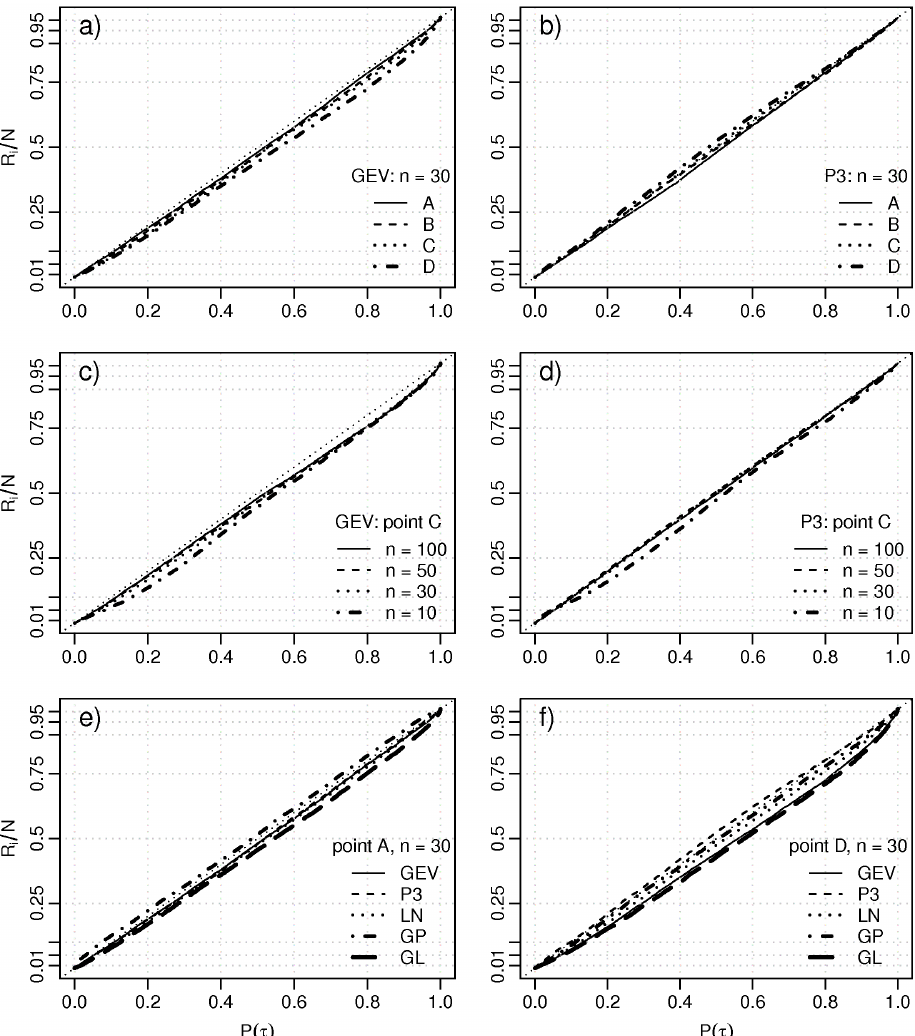
Fig. 4. Probability plot representation of P(τ) when assuming the log-Student t distribution of Eq. (14) and applying the corrections of Eqs. (16) and (17). The same cases (a – f) of Fig. 2 are considered here. for the standard deviation of the sample L-CV (panel (b)